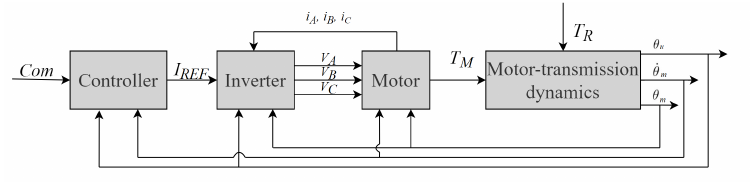
Figure 6. RM model structure as taken from